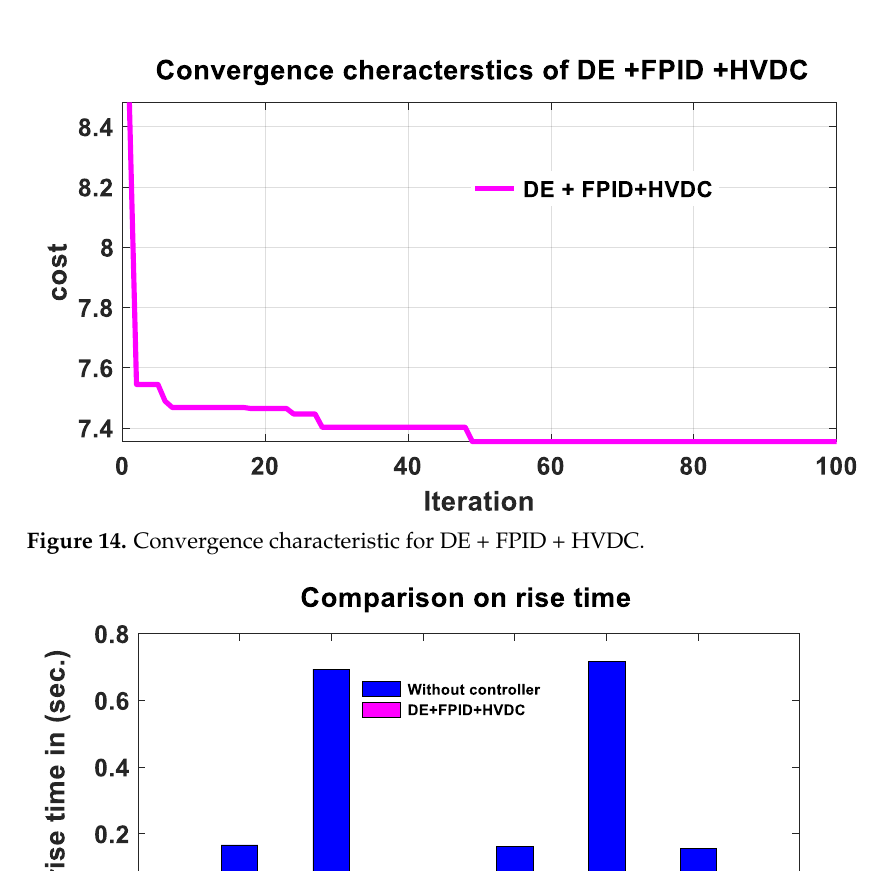
Figure 13. Comparison of controller and without controller + HVDC for change in tie-line power deviation P23.